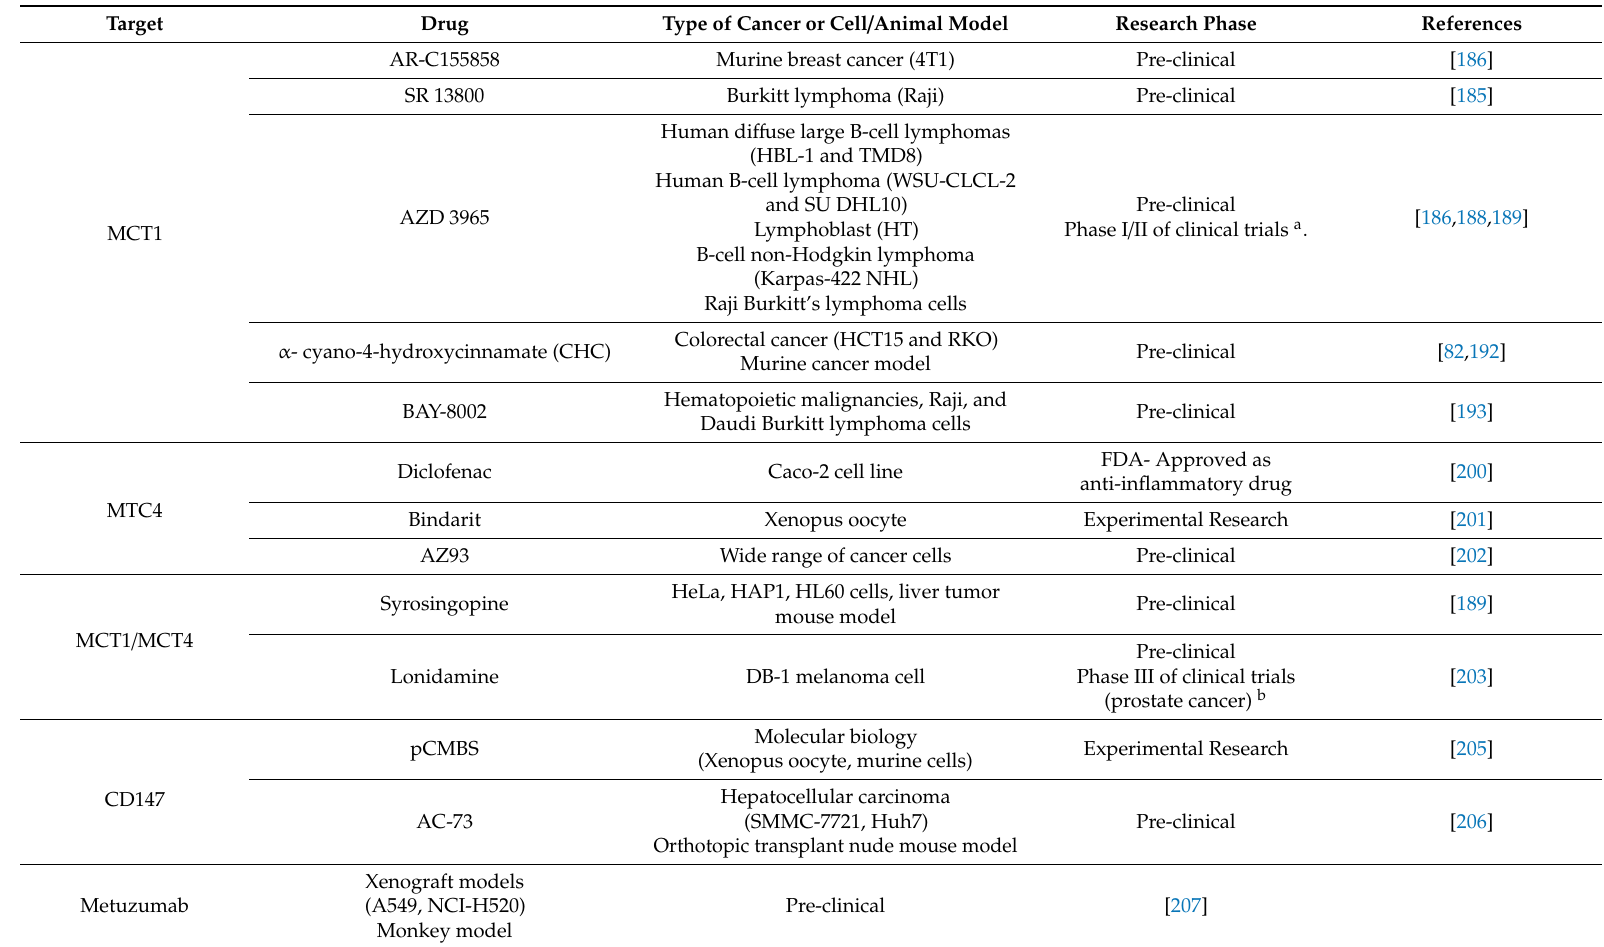
Table 2. Compounds to inhibit lactate